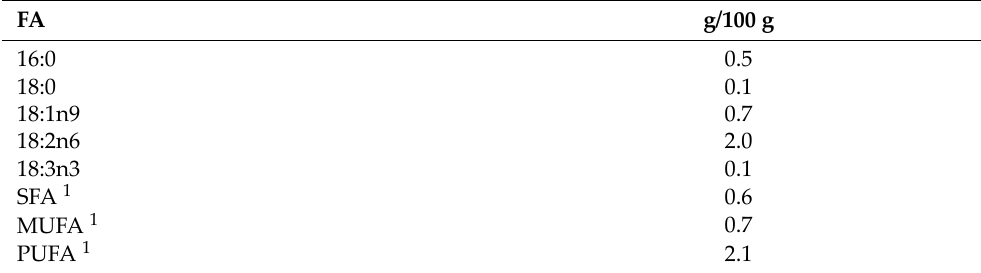
Table 3. Main dietary fatty acid (FA) composition (g/100 g diet) of 2016 Teklad Global control diet as reported by the manufacturer Envigo. Dietary experimental treatments: control diet (Ctrl), control